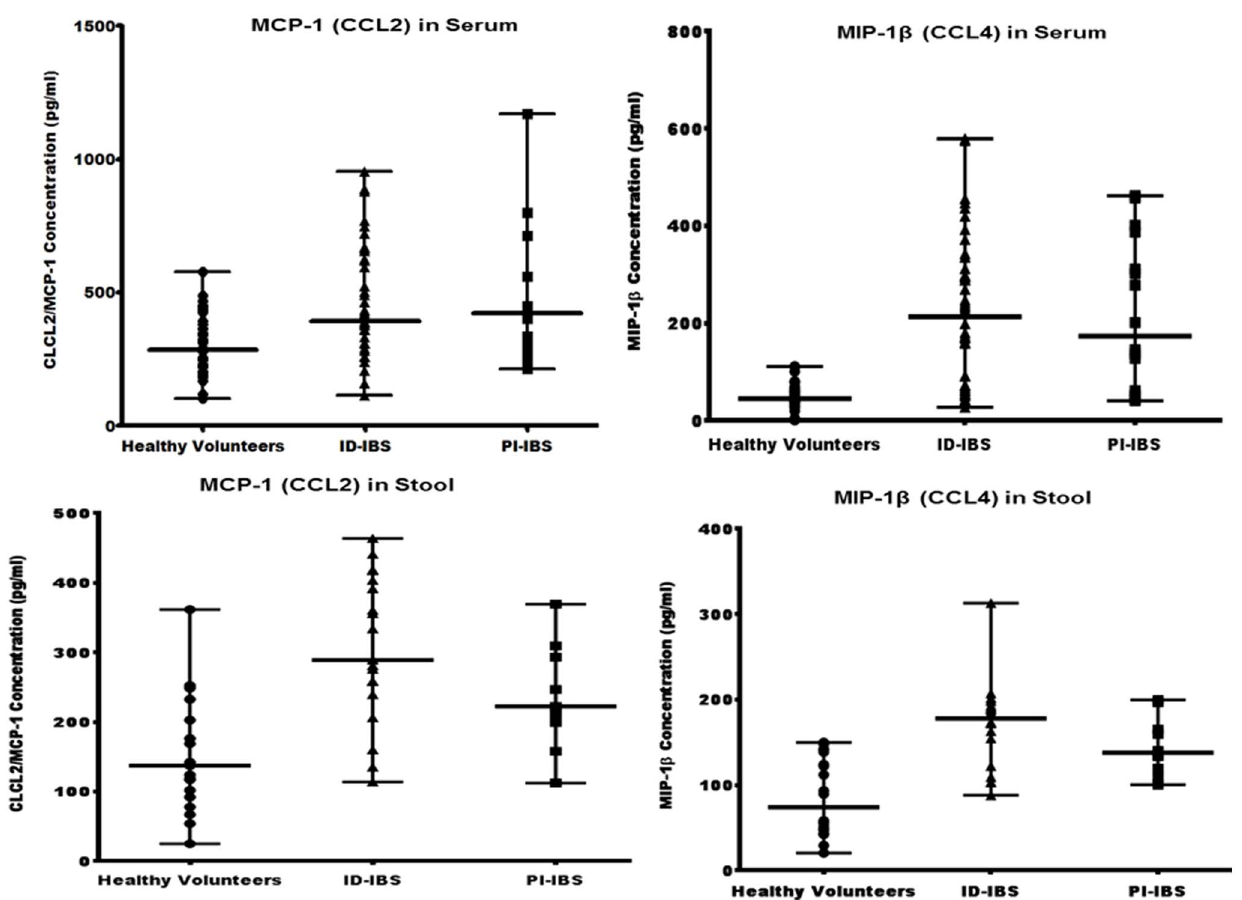
Figure 3. The sera and fecal concentrations of MCP-1 and MIP-1 b in IBS patients are significantly higher than healthy volunteers. Sera and stool samples from IBS patients were examined for the concentrations of MCP-1 and MIP-1 b by quantitative ELISA (R&D Systems, Minneapolis, MN). Mann Whitney test showed significant differences between the medians of the healthy volunteers versus ID-IBS (P , 0.001) and PI- IBS (P , 0.0048) for MCP-1; ID-IBS (0.0001), PI-IBS (0.001) for MIP-1 b . The medians of ID-IBS versus PI-IBS were not significantly different (P=0.9267 for MCP-1; P=0.5308 for MIP-1 b ). Error bars indicate median values with range.